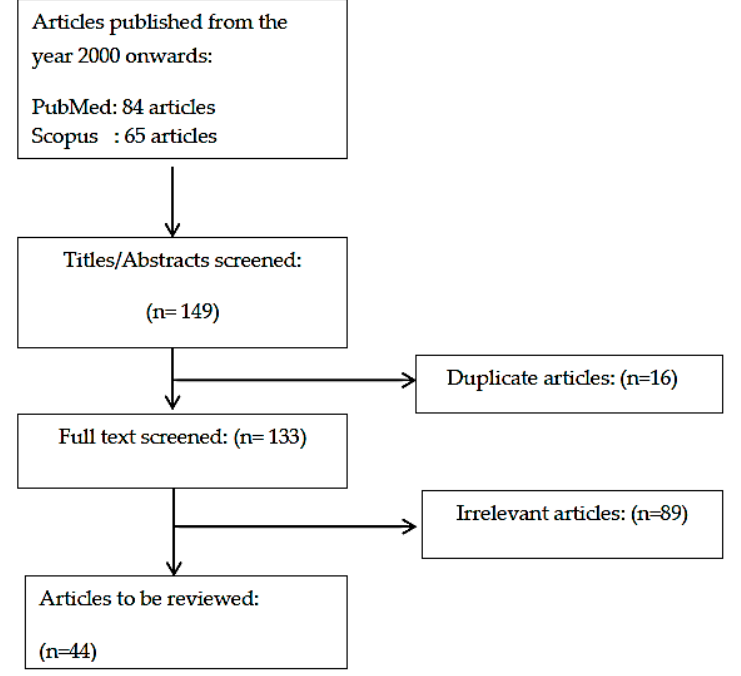
Figure 1. Flowchart of literature search.